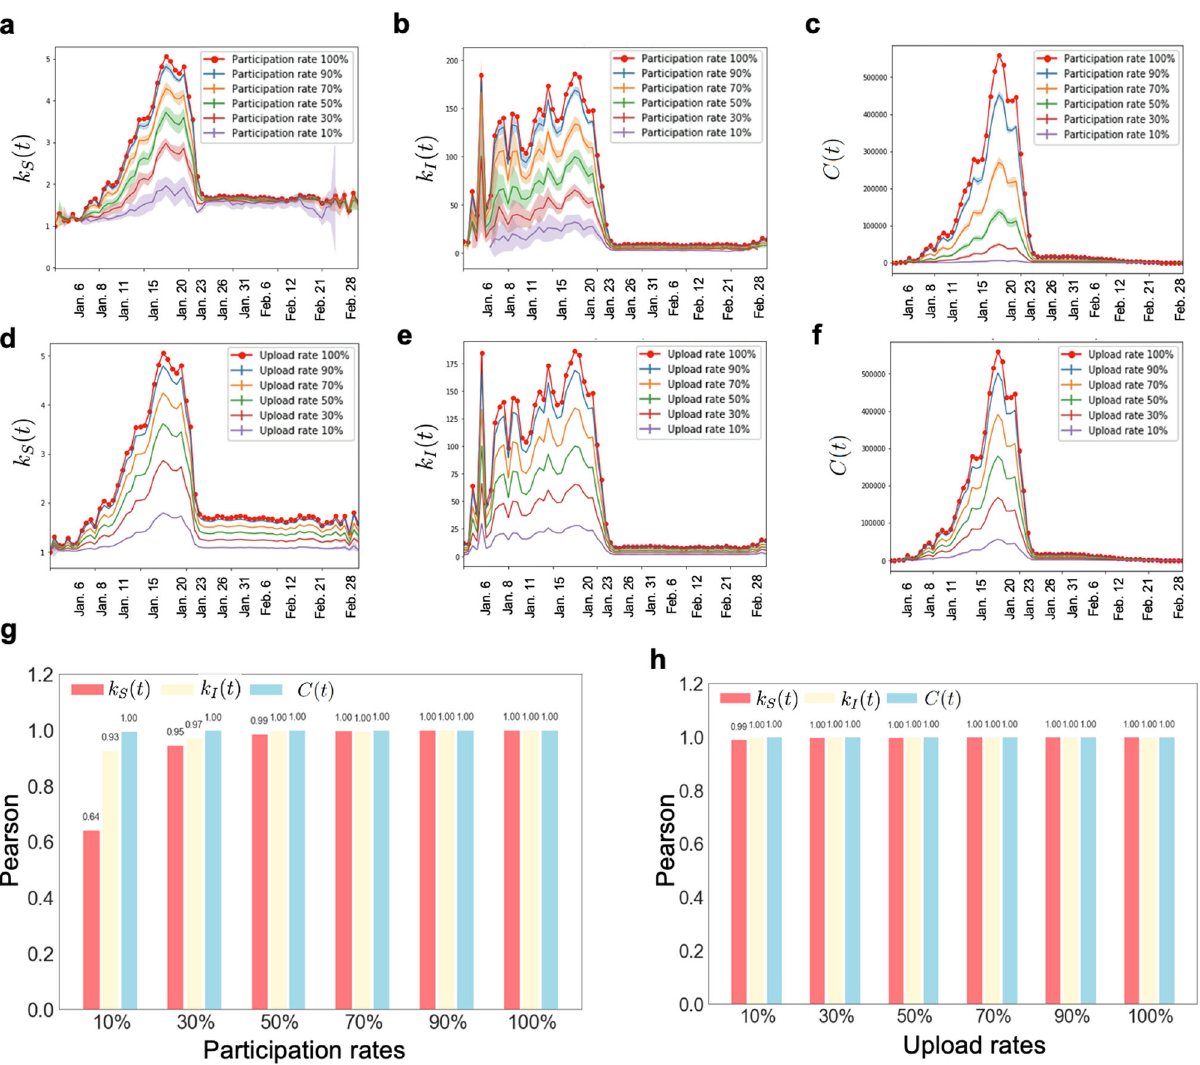
Fig. 4 The performance of contact tracing under different user involvements. a – c Three fi gures show the change of the average degree of susceptible nodes k S ( t ), the average degree of infectious nodes k I ( t ), and the number of edges C ( t ) from 1 January to 28 February with error bars vs. different user participation rates. The error bar indicates the standard deviation of a ten-times repeating experiment. d – f Three fi gures show the change of daily k S ( t ), k t ), and C ( t ) from 1 January to 28 February with error bars vs. different user upload rates. The error bar indicates the standard deviation of a ten-times I ( repeating experiment. g , h The Pearson correlations vs. different user participation rates and user upload